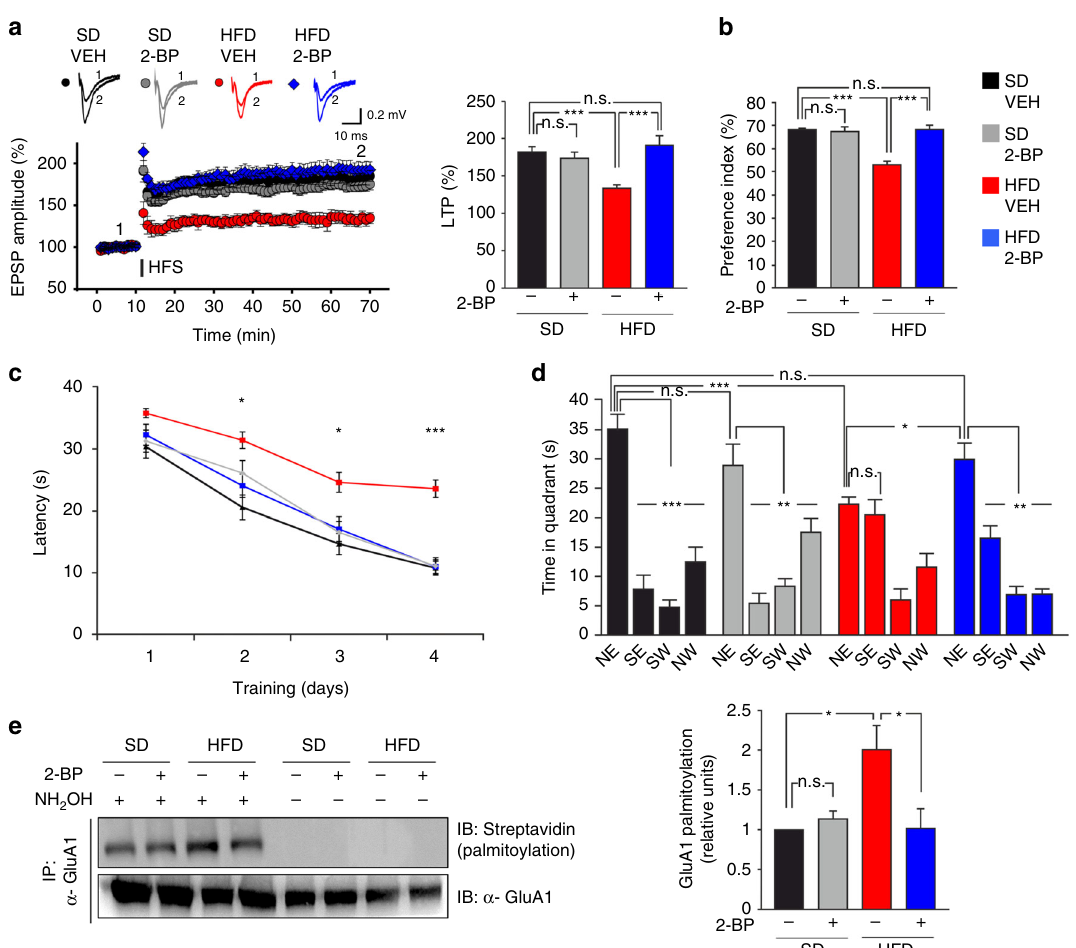
Fig. 6 2-BP reverts GluA1 palmitoylation and rescues both synaptic plasticity impairment and memory loss induced by HFD. a Time course (left) of LTP at CA3-CA1 synapses induced by HFS delivered at time 10 (line) in hippocampal slices of mice fed with SD or HFD for 6 weeks and intranasally injected with vehicle or 2-BP (SD VEH , SD 2-BP , HFD VEH , HFD 2-BP ; n = 12 slices per each group). Results are expressed as percentages of baseline EPSP amplitude ( = 100%). Insets (top) show representative EPSPs at baseline (1) and during the last 5 min of LTP recording (2). On right, LTP recorded during the last 5 min (statistics by two-way ANOVA and Bonferroni post hoc). b Preference for the novel object in NOR paradigm ( n = 9 for each group; statistics by two-way ANOVA and Bonferroni post hoc). c Latency to reach the hidden platform in MWM test ( n = 9 for each group; signi fi cance is indicated between SD VEH or HFD 2-BP and HFD VEH mice; statistics by two-way ANOVA and Bonferroni post hoc). d Time spent in the four quadrants during probe test of MWM test. NE is the target quadrant ( n = 9 for each group; statistics by two-way ANOVA and Bonferroni post hoc). e Immunoblots (left) of palmitoylated GluA1 (top) and total immunoprecipitated protein (bottom) in hippocampi of SD and HFD mice. On right, densitometry of palmitoylated GluA1/total immunoprecipitated GluA1 amount ratio ( n = 4; statistics by two-way ANOVA and Bonferroni post hoc). Data are expressed as mean ± SEM * p < 0.05; ** p